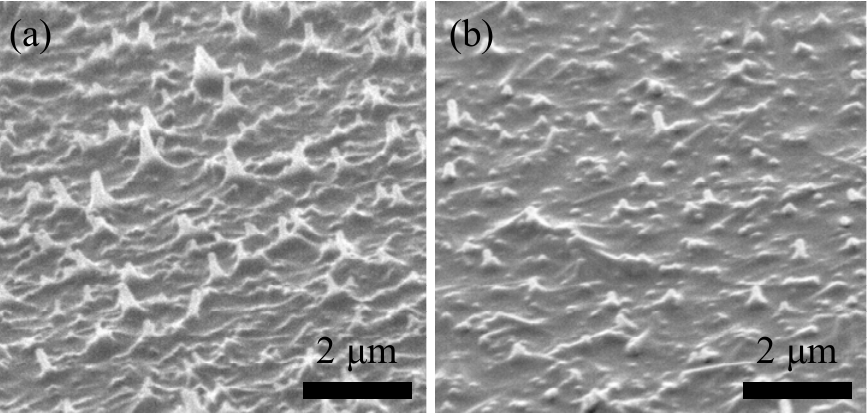
Figure 6. Scanning electron microscope (SEM) images of the C layer ( a ) before and ( b ) after the SVT at 21.6 vol % concentration at 25 °C for 20